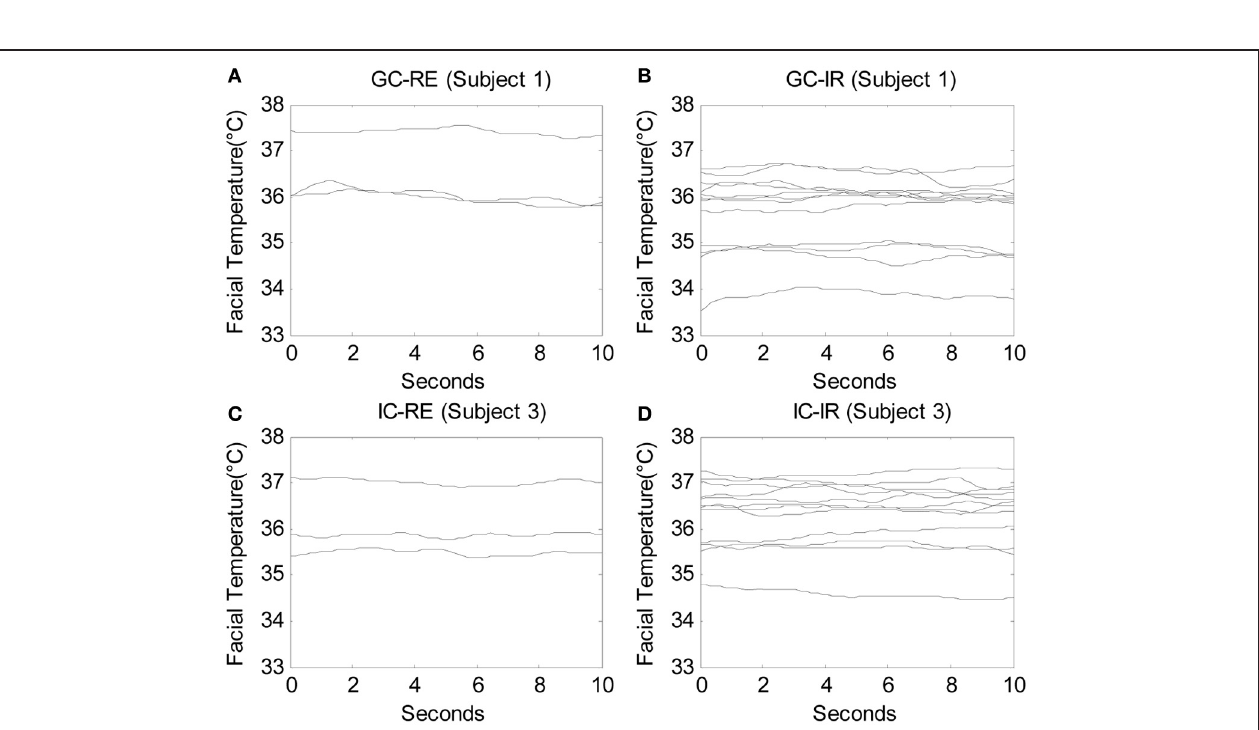
answering (C) 3 relevant questions and (D) 12 irrelevant questions, in which each line indicates the facial temperature for each question.